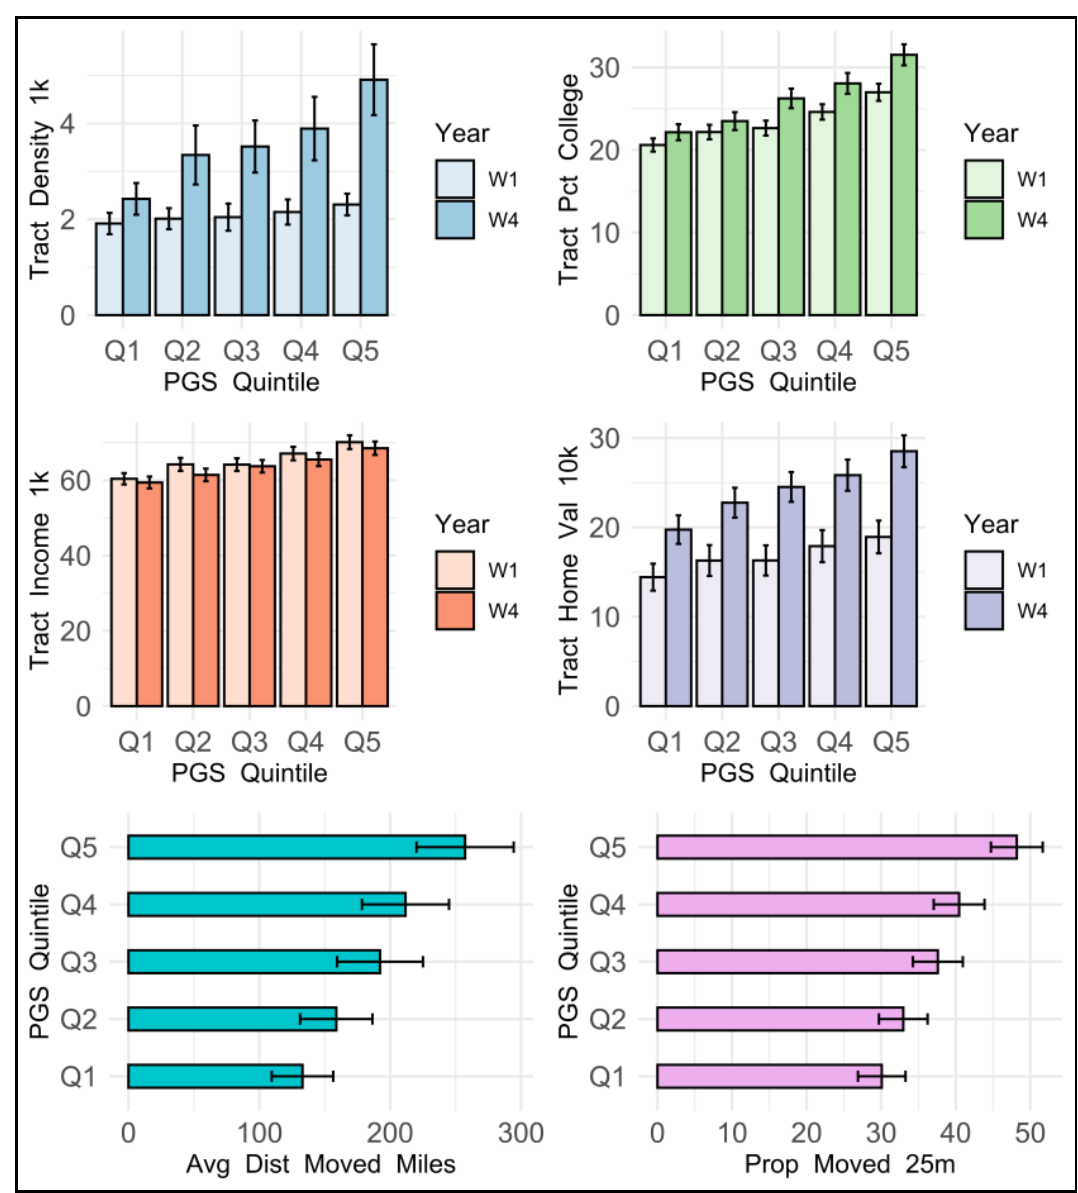
Figure 2: Means and standard errors for neighborhood characteristics in waves 1 and 4, distance between wave 1 and wave 4 locations, and proportion who migrated more than 25 miles by education PGS quintile. 1k, 1,000; Avg, average; Dist, distance; m, miles; Pct, percentage; Prop, proportion; Q1, quintile 1; Q2, quintile 2; Q3, quintile 3; Q4, quintile 4; Q5, quintile 5; Val, value; W1, wave 1; W2, wave 2; W3, wave 3; W4, wave 4.